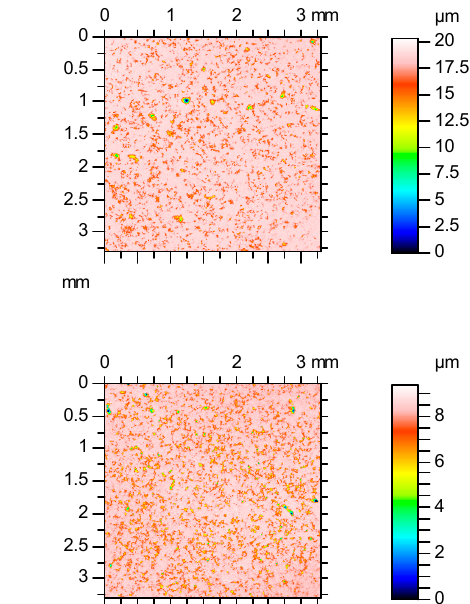
Figure 11. Material ratio curves of surfaces shown in Figure 10. Figure 12 presents selected dependencies between the surface parameters after abrasive blasting followed by lapping.